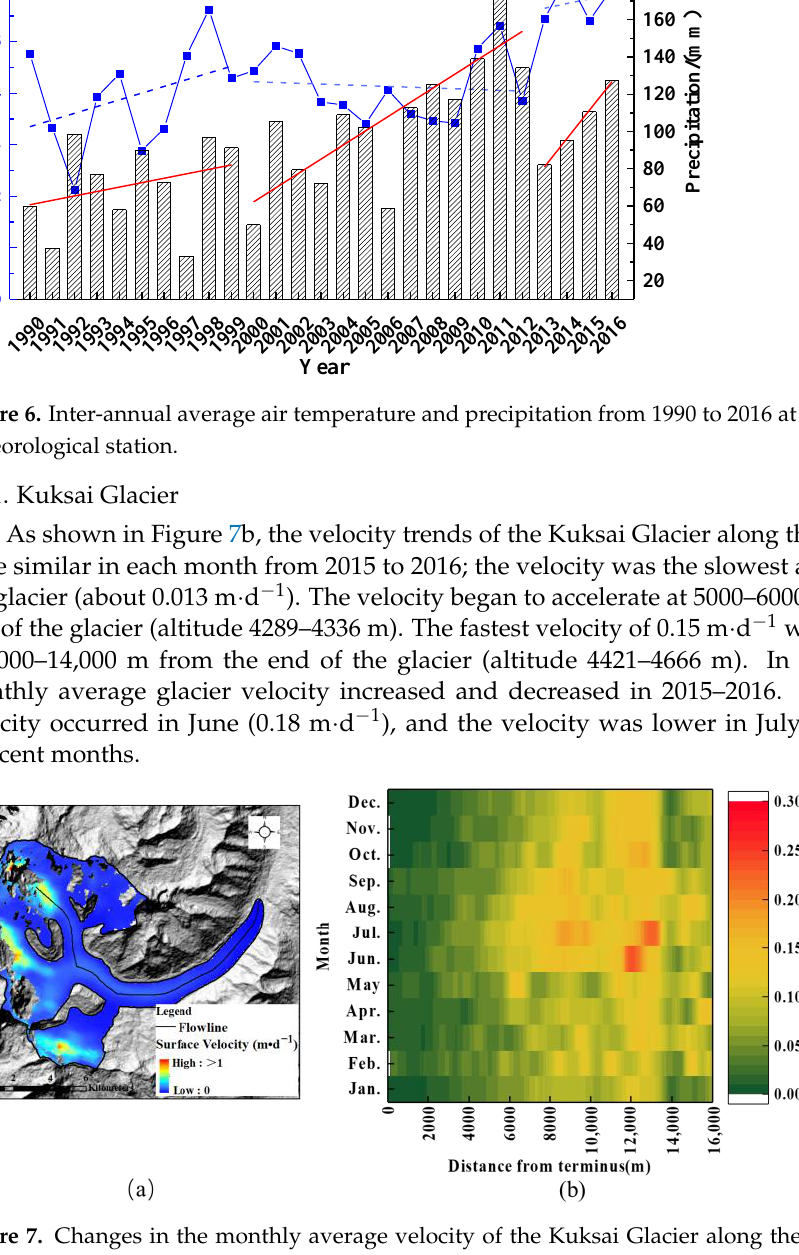
Figure 7. Changes in the monthly average velocity of the Kuksai Glacier along the centerline in 2015 – 2016. ( a ) Monthly average velocity along the centerline in 2015 – 2016. ( b ) Monthly average velocity during 2015 –